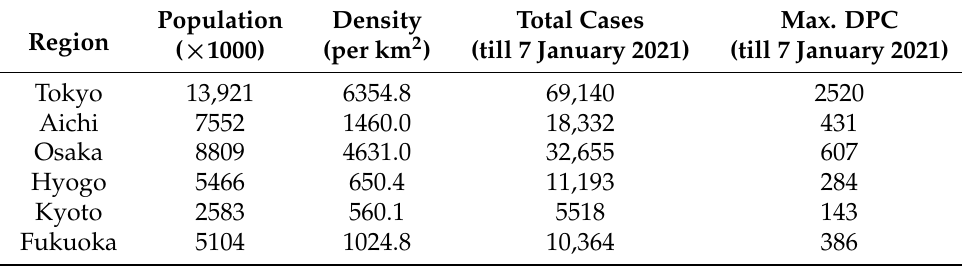
Table 2. Population, population density, total cases, and maximum DPC of study